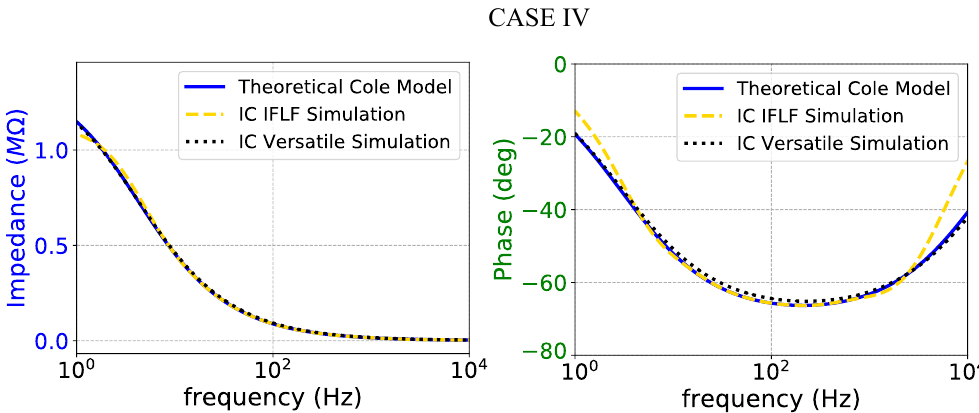
Figure 25. Impedance magnitude ( left ) and phase response ( right ) of the case III fractional-order skin model.